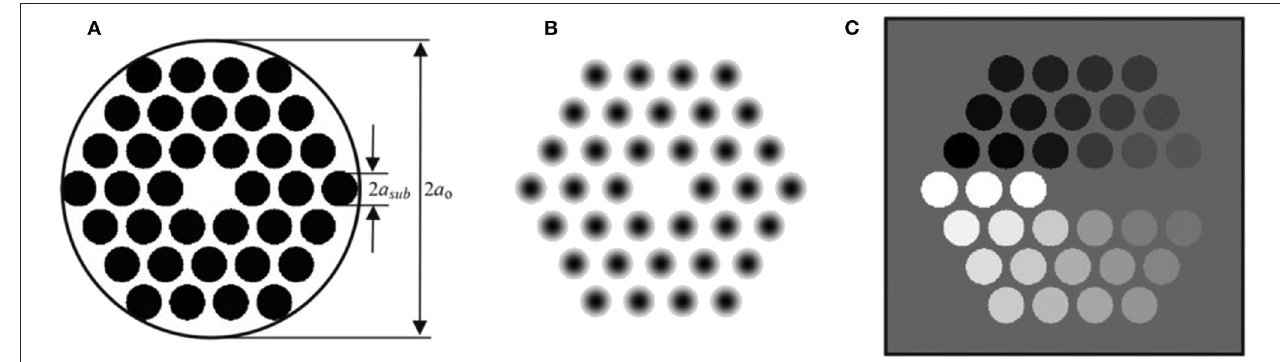
FIGURE 3 | Geometry of subaperture arrangement (A) , intensity (B) , and phase (C) distribution for the synthesized beam of 36 subapertures in the plane; l